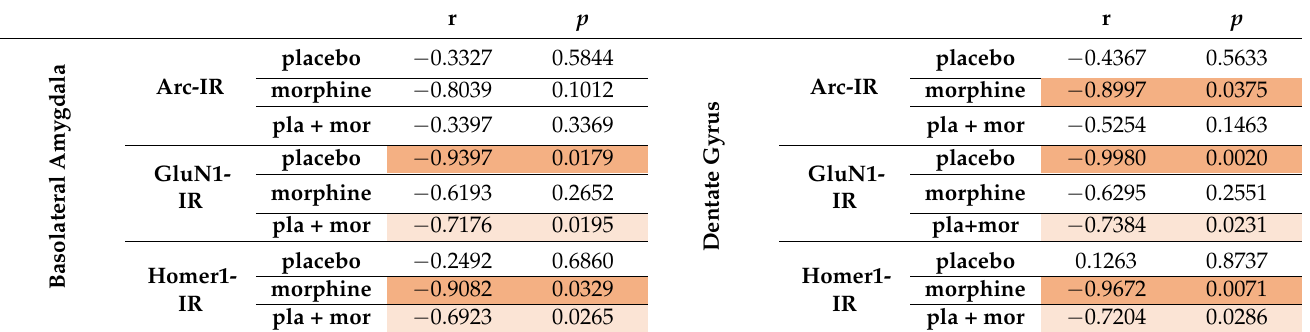
Table 2. Correlations between the extinction, measured as the difference in time spent in the naloxone- associated compartment in the extinction test minus that in the CPA test, and Arc-, GluN1-, and Homer-IR in the BLA and